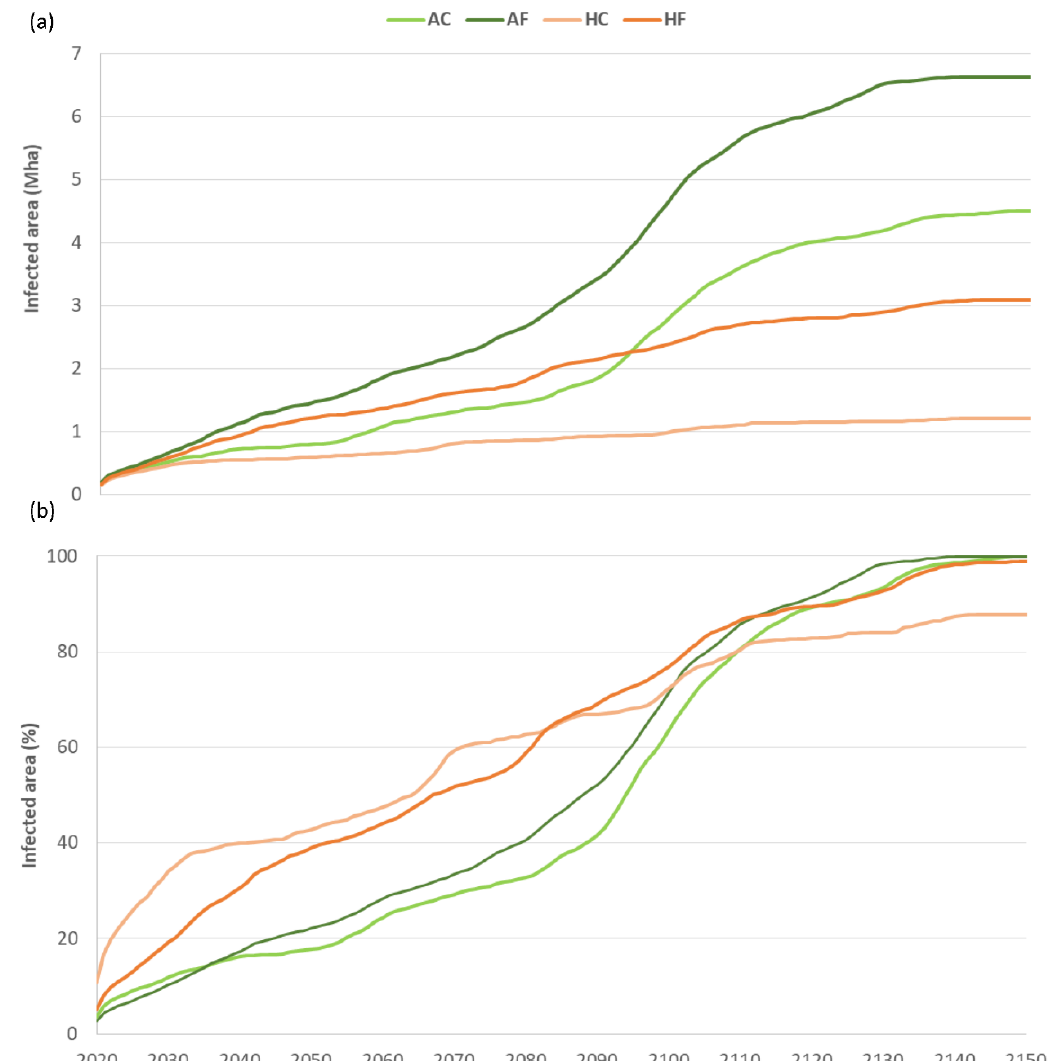
Figure 3. Infected area projections in the Iberian Peninsula for the four considered scenarios (AC, AF, HC and HF) up to the year 2150. Results are expressed in ( a ) as the forest area infected (Mha) and in ( b ) as the percent of the total forest area in the Iberian Peninsula that is infected. Projections consider all pine tree forest for Scenarios AC and AF (under current and future climate, respectively) and only the pine forest composed of highly susceptible species for Scenarios HC and HF (under current and future climate, respectively). Infected area corresponds to the cells with a probability of infection higher than 0.9 for a given year in the spread modelling. The asymptotes reached by the projections extend indefinitely beyond 2150 (all values remain constant up to 300 years of model runs).